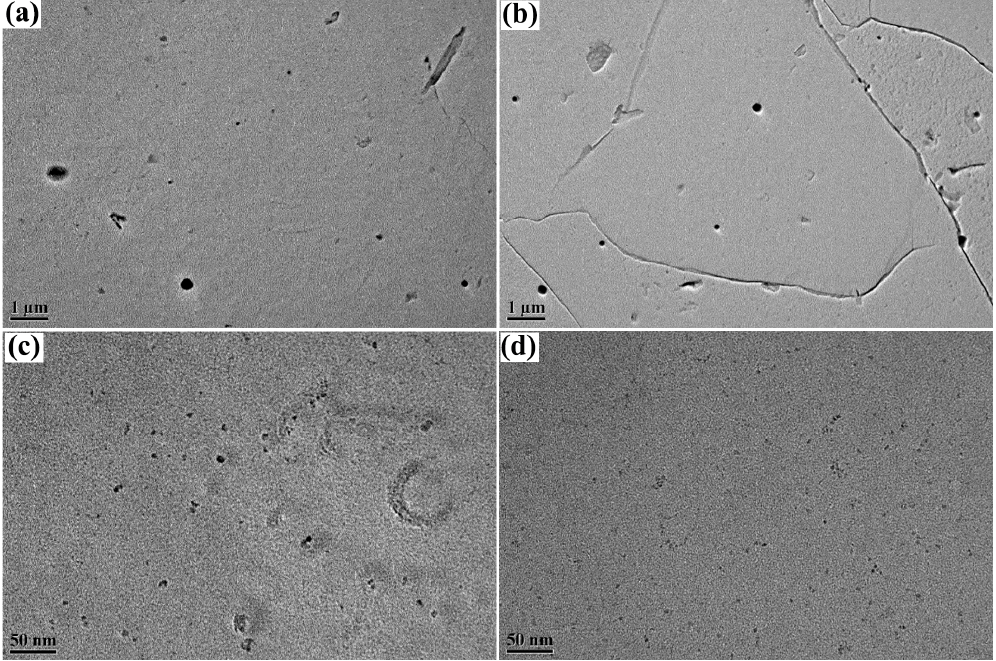
Figure 8. Nano precipitates of test steel at di ff erent coiling temperatures: ( a , c ) 650 °C; ( b , d ) 600 °C.